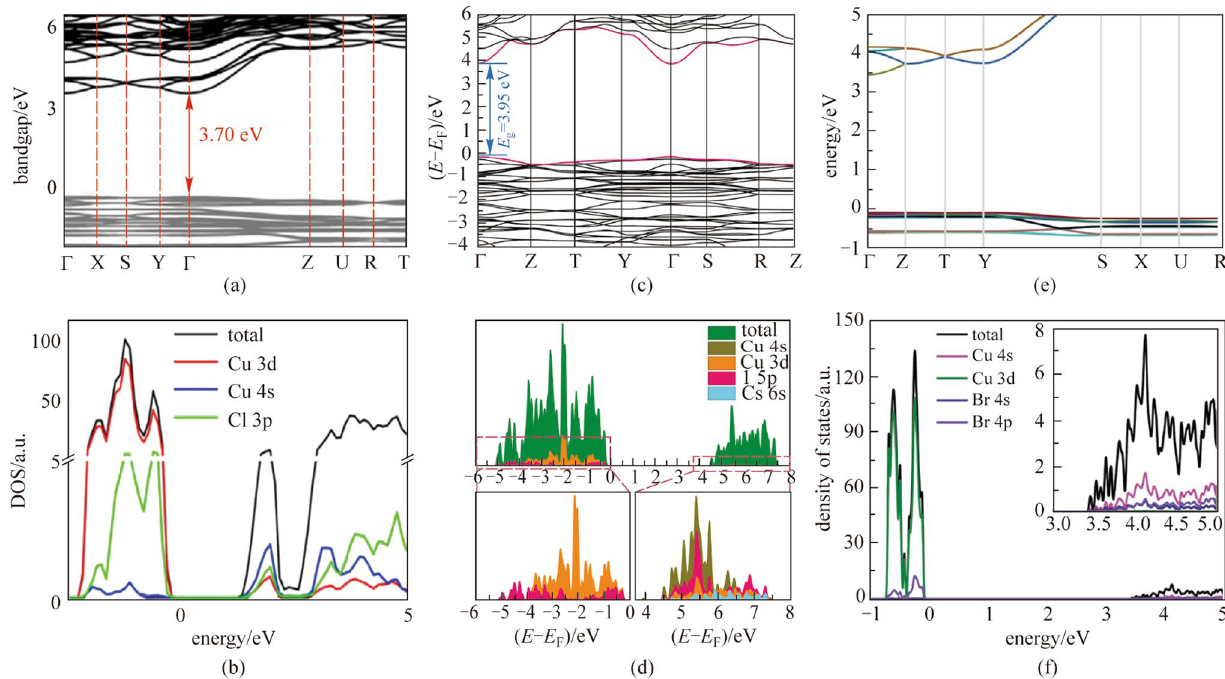
Fig. 3 Electronic properties of Cs 3 Cu 2 Cl 5 : a Electronic band structure, b PDOSs. Reprinted with permission from Ref. [54], Copyright 2020, WILEY–VCH Verlag GmbH; Electronic properties of CsCu 2 Cl 3 : c Electronic band structure, d PDOSs. Reprinted with permission from Ref. [36], Copyright 2021, ELSEVIER; Electronic properties of Rb 2 CuBr 3 : e Electronic band structure, f PDOSs. Reprinted with permission from Ref. [37], Copyright 2019, WILEY–VCH Verlag